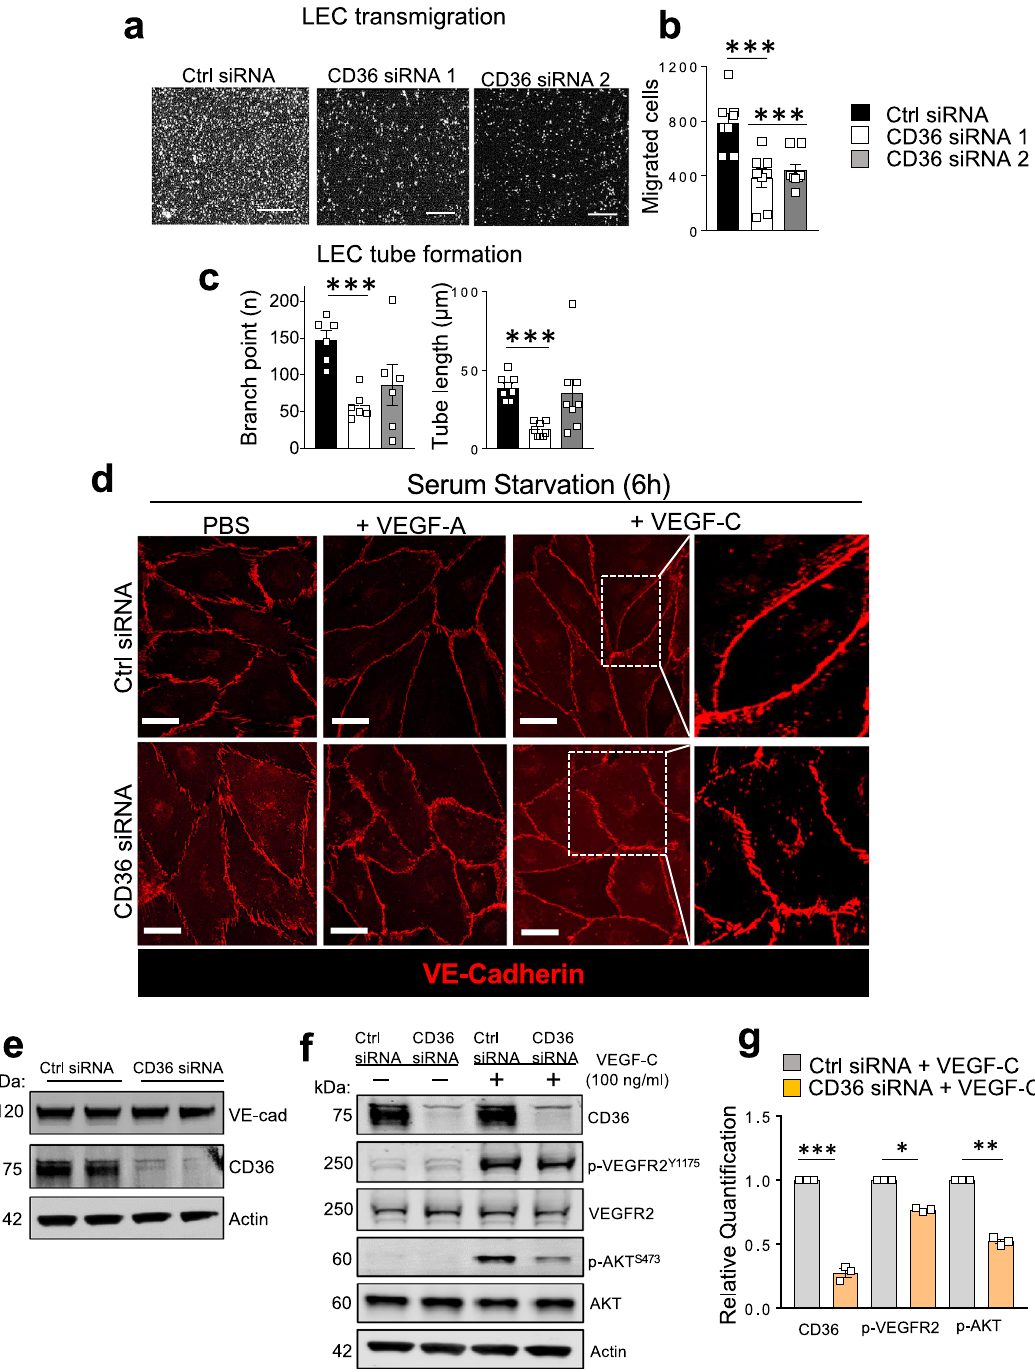
Fig. 8 CD36 deletion impairs lymphatic endothelial cell function, VE-cadherin morphology, and VEGFR2/AKT activation. Human dermal lymphatic endothelial cells (LECs) are transfected with either control (Ctrl siRNA) or CD36 Silencer ® Pre-designed siRNA (CD36 siRNA1 and 2). a , b VEGF-C mediated migration (both siRNAs P < 0.001) ( n = 8 per condition). Scale bar: 500 µ m. c Tube formation: CD36siRNA1: branch points P = 0.047; tube length P = 0.04 versus Ctrl siRNA ( n = 8 – 6 per condition). d Fully con fl uent Ctrl siRNA and CD36 siRNA 1 LECs ( n = 3/condition) are serum starved (6 h) and exposed to VEGF-C (100 ng/ml) or VEGF-A (50 ng/ml) for 20 min. Immunohistochemistry of VE-cadherin depicts junctional morphology in Ctrl and CD36 siRNA LECs following treatments. e VE-cadherin and CD36 expression in Ctrl and CD36 siRNA LECs. f Western blot analysis and (g) densitometric quanti fi cation of CD36 ( P < 0.001), VEGFR2, p-VEGFR2 Y1175 ( P < 0.05), AKT, p-AKT S473 ( P < 0.01) expression in Ctrl and CD36 siRNA LECs ( n = 3 per condition) following the addition of VEGF-C (100 ng/ml, 20 min). Actin protein is the loading control. VE-cad, VE-cadherin; kDa, kilodalton. Data are representative of two independent experiments and are means± SE. Statistical signi fi cance is determined by two-tailed Student t test. * P < 0.05; ** P < 0.01; *** P <